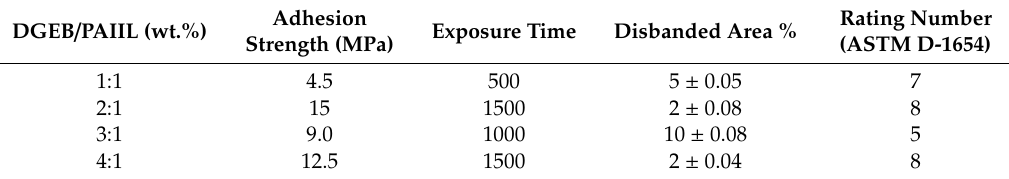
Table 3. Salt spray resistance of DGEB / PAIIL coating films at di ff erent exposure times 720. DGEB / PAIIL (wt.%)